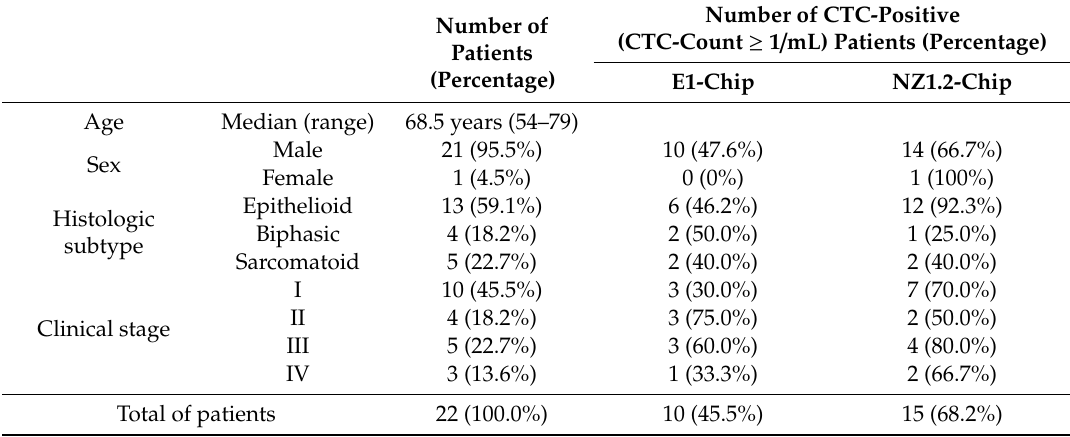
Table 1. Characteristics of patients and detection of CTCs with the